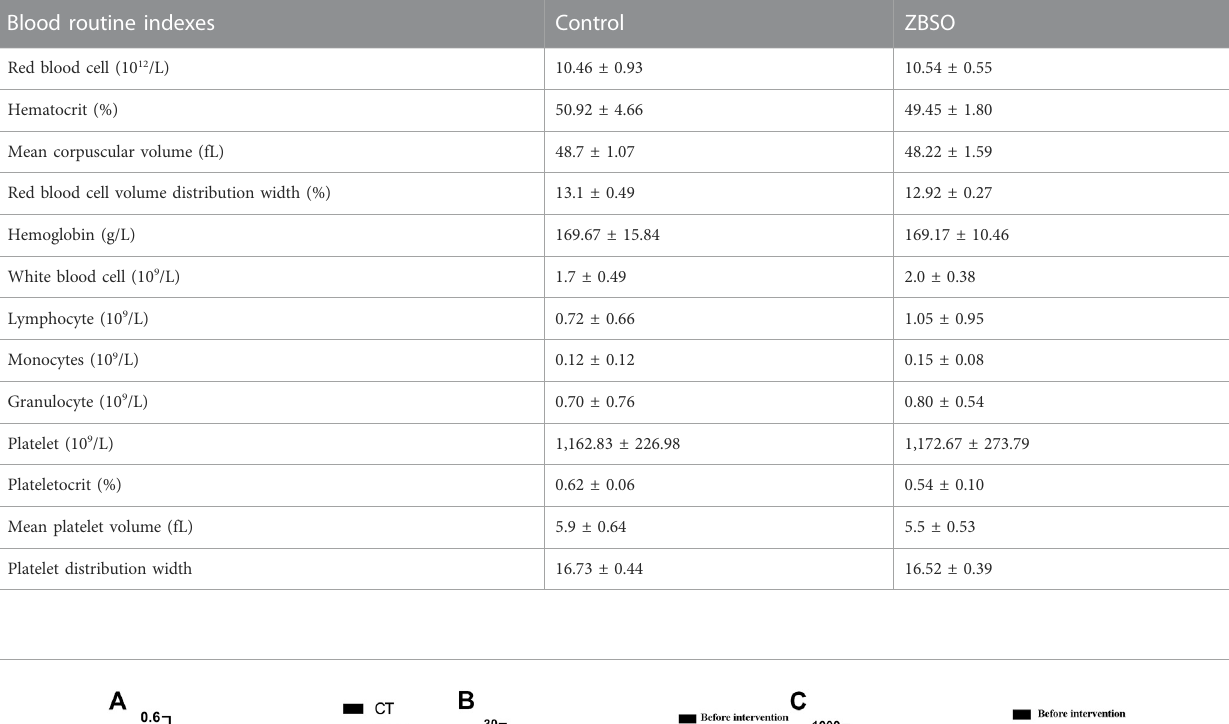
TABLE 1 The effects of ZBSO on blood routine indexes of nude mice.